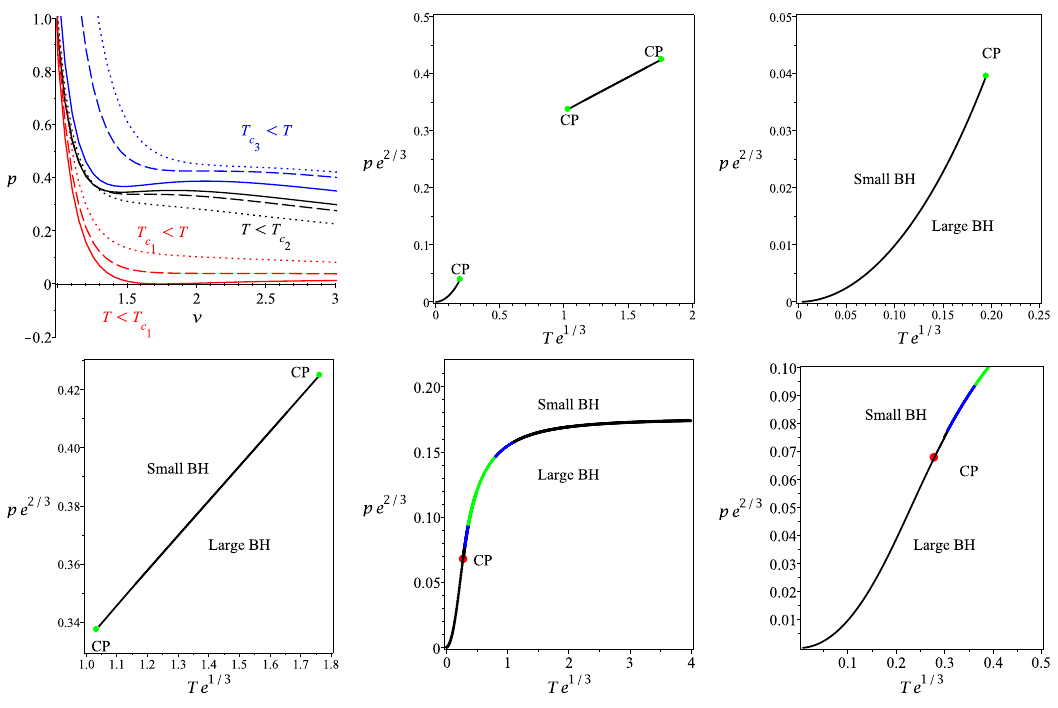
Figure 12 . Three (cid:12)rst order phase transition in six dimensions for d = 6 and k = 1 (color online). Top left : the reverse VdW transition occurs at intermediate temperatures between two standard VdW transitions, with curves below (solid), at (dashed), and above (dotted) critical temperature displayed for each. For the cold VdW transition, T = T c (dashed red line), T = 0 : 60613 T c (solid 1 1 red line) T = 1 : 7 T c (dotted red line); for the reverse VdW one T = 0 : 8 T c (dotted black line), 1 2 T = T c (dashed black line), T = 1 : 1 T c (solid black line); for the hot VdW transition T = 0 : 8 T c 2 2 3 (solid blue line), T = T c (dashed blue line) and T = 1 : 1 T c (dotted blue line). Top center : the phase 3 3 diagram, with green dots denoting the critical points and black lines indicating three (cid:12)rst order phase transitions for temperatures smaller and larger than the three illustrated critical points; we have chosen e = 1, (cid:12) 3 = (cid:0) 3 = 5 e 4 = 3 and (cid:11) 4 = (cid:0) 4 = 5 e 2 , with T c e 1 = 3 (cid:25) 0 : 19440, P c e 2 = 3 (cid:25) 0 : 03960 and 1 1 T c e 1 = 3 (cid:25) 1 : 03337, P c e 2 = 3 (cid:25) 0 : 33752 and T c e 1 = 3 (cid:25) 1 : 76108, P c e 2 = 3 (cid:25) 0 : 42503. Top right and bot- 2 2 3 3 tom left : close ups of the curves of the top center plot. Bottom center : for e = 1, (cid:12) 3 (cid:25) (cid:0) 2 : 04428 e 4 = 3 and (cid:11) 4 = (cid:0) 4 = 5 e 2 we obtain an isolated critical point (in red); numerically we (cid:12)nd that the critical temperature and pressure are T c e 1 = 3 (cid:25) 0 : 27826 and P c e 2 = 3 (cid:25) 0 : 06790. Blue and green lines show negative entropy and negative mass respectively. Bottom right : a magni(cid:12)cation of the bottom center plot close to the isolated critical